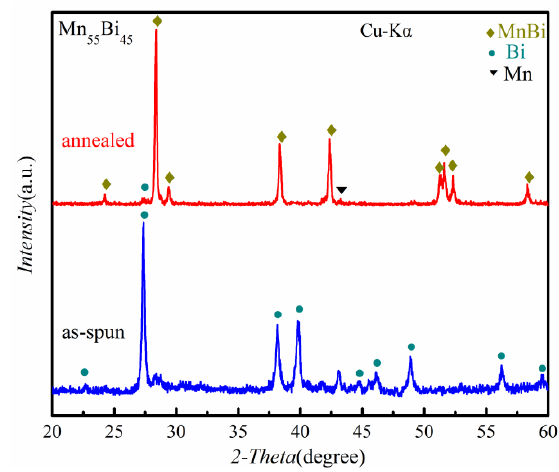
Figure 1. X-ray diffraction (XRD) patterns of Mn 55 Bi 45 powders before and annealed at 573 K for 30 min.